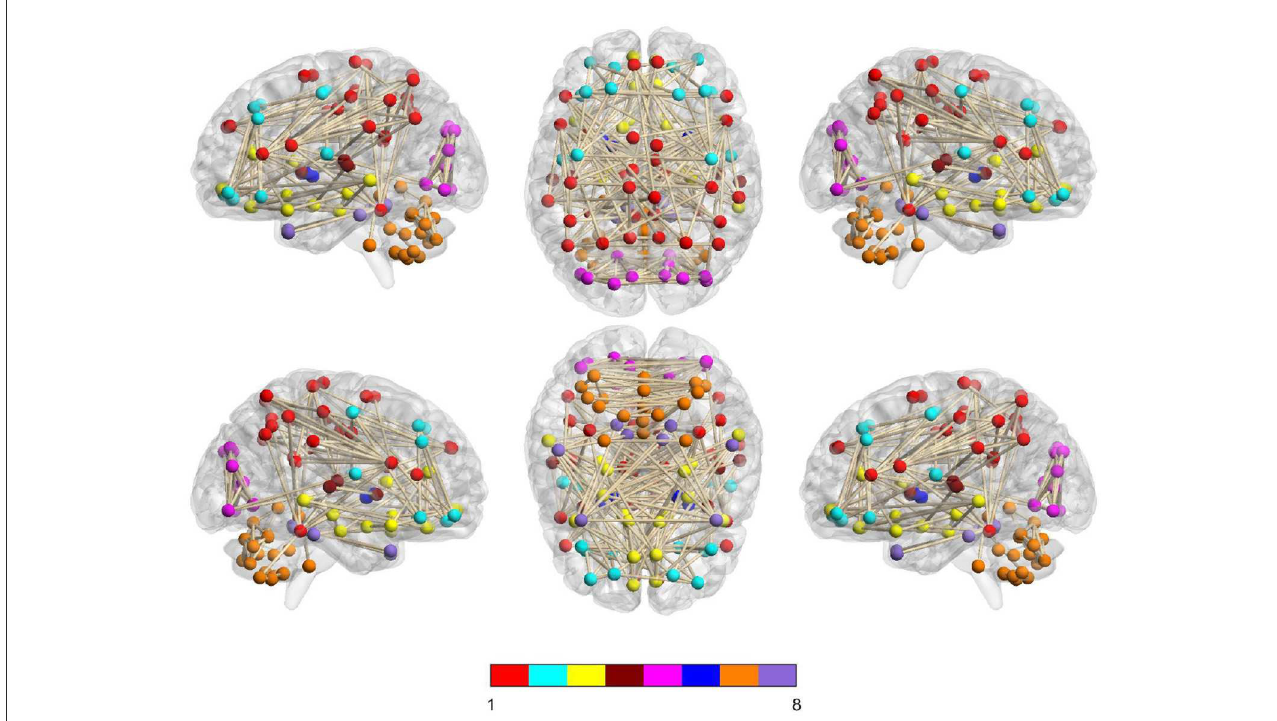
FIGURE7 Identified 8 modules of the average network (among training subjects) on the brain template, where nodes with the same color belong to the same module.